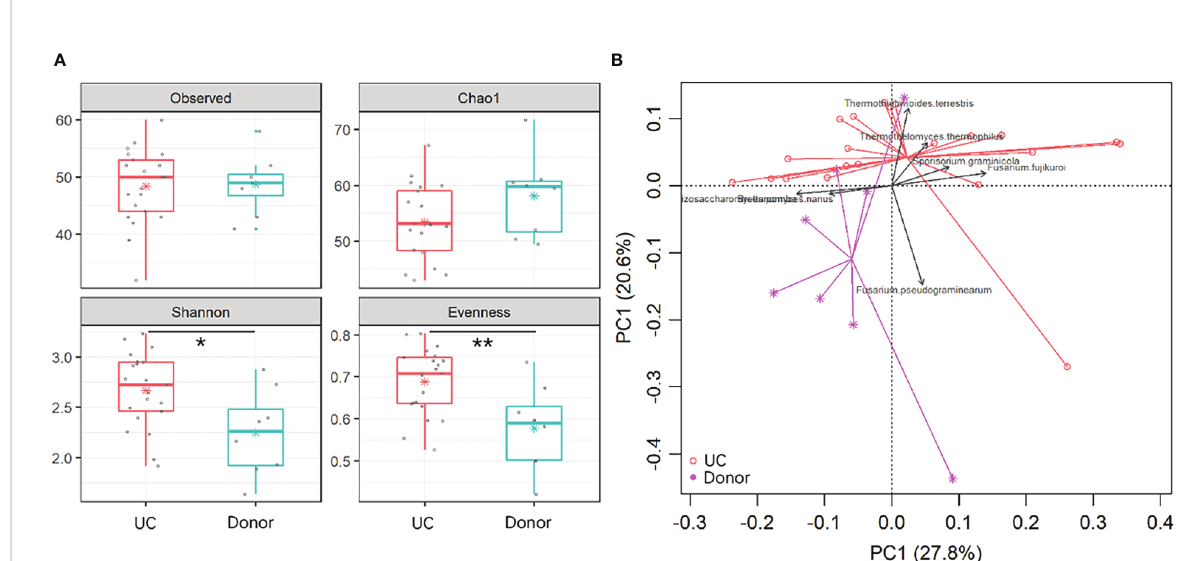
FIGURE 2 Dysbiosis of gut fungal communities in UC patients. (A) a -diversity indices in UC patients and donors were analyzed, including observed OTUs, Chao 1, and Shannon and Pielou ’ s evenness indices. The asterisk indicated statistical differences between the two groups, * p ≤ 0.05,** p ≤ 0.01,. (B) Clusters of gut fungal communities were analyzed using PCA of the fungal species by the Euclidean distance. The top 7 species were fi tted to PCA with a signi fi cance cutoff at p < 0.05.